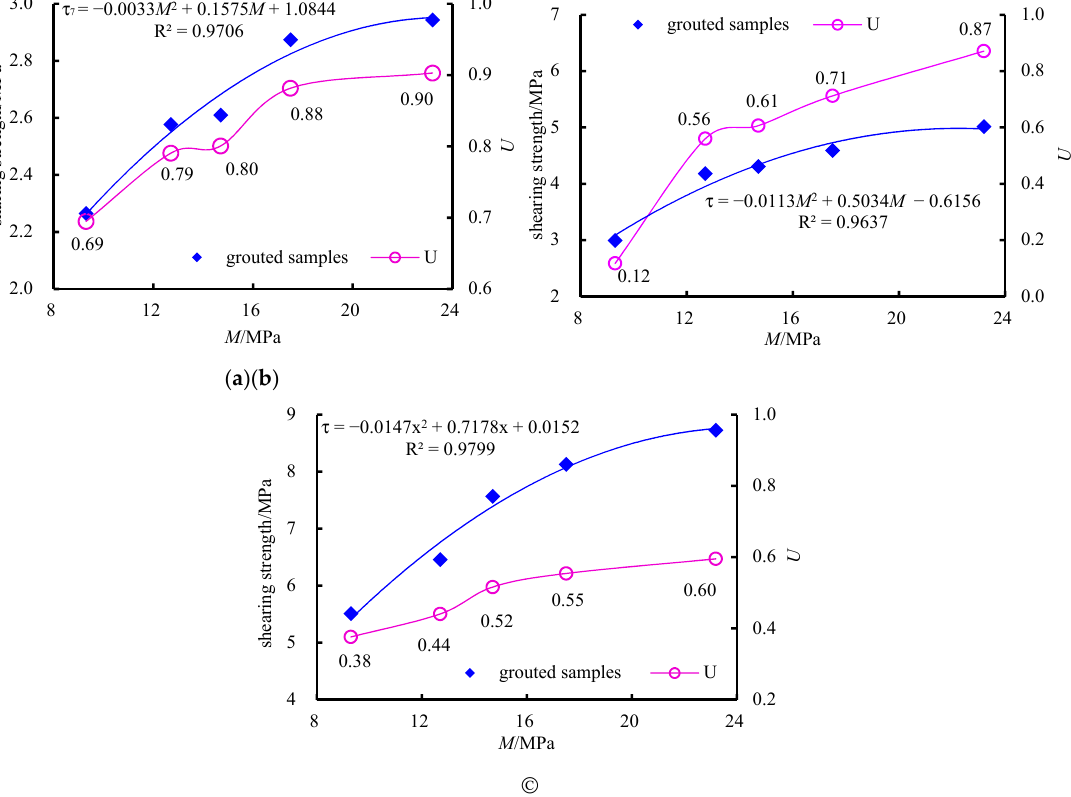
Figure 11. Growth characteristics of shearing strength of samples in di ff erent M : ( a ) Growth characteristics of shearing strength of 7 MPa samples; ( b ) growth characteristics of shearing strength of 16 MPa samples; ( c ) growth characteristics of shearing strength of 26 MPa samples.